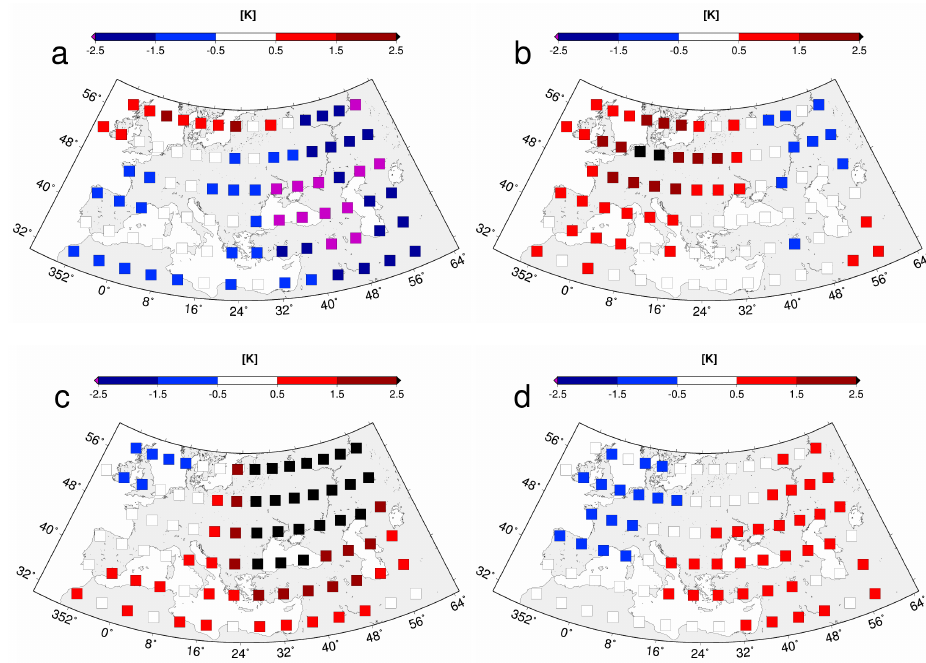
Fig. 4. Same as Fig. 2, but for mean temperature